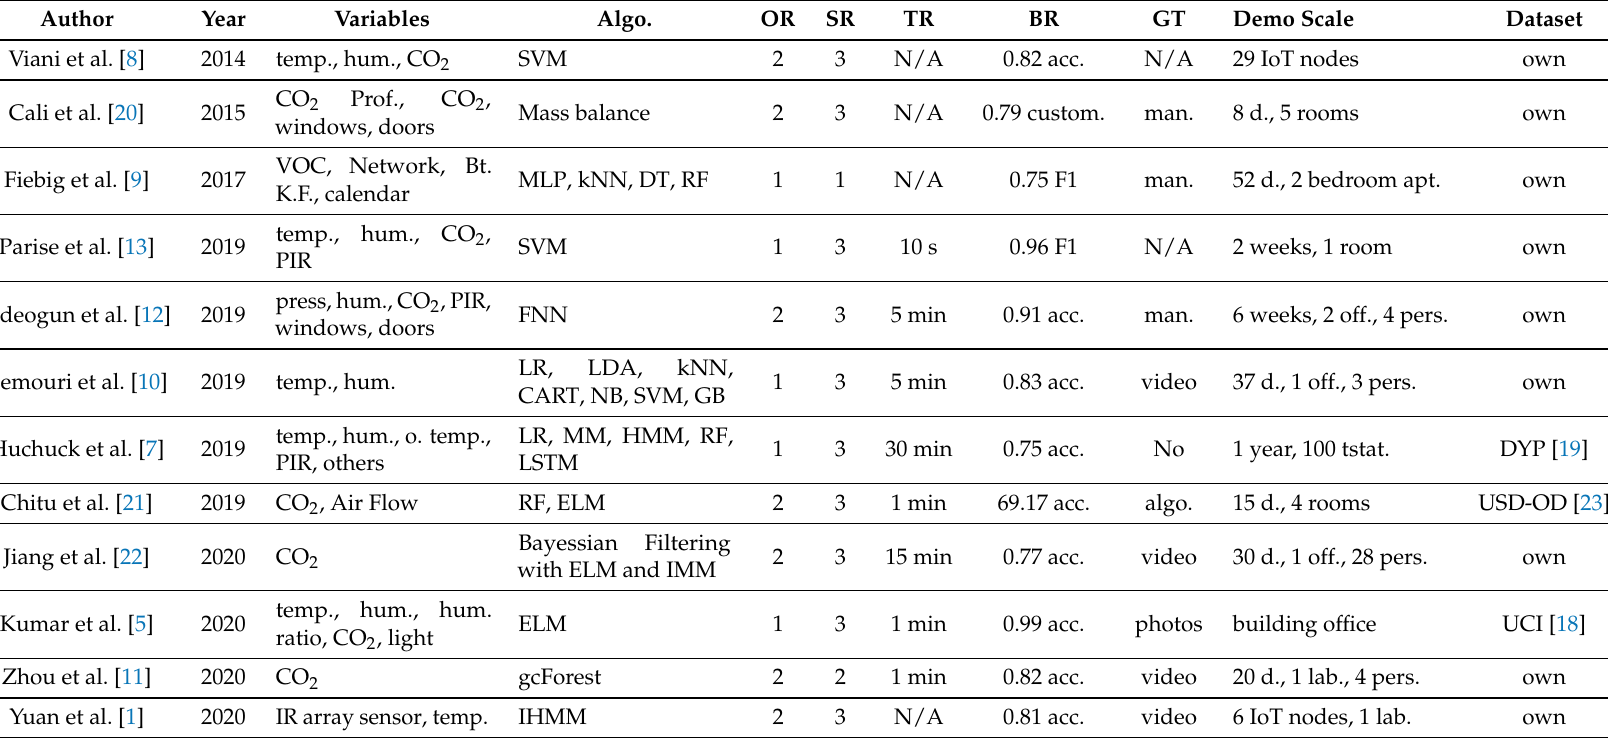
Table 1. Summary of the reviewed related